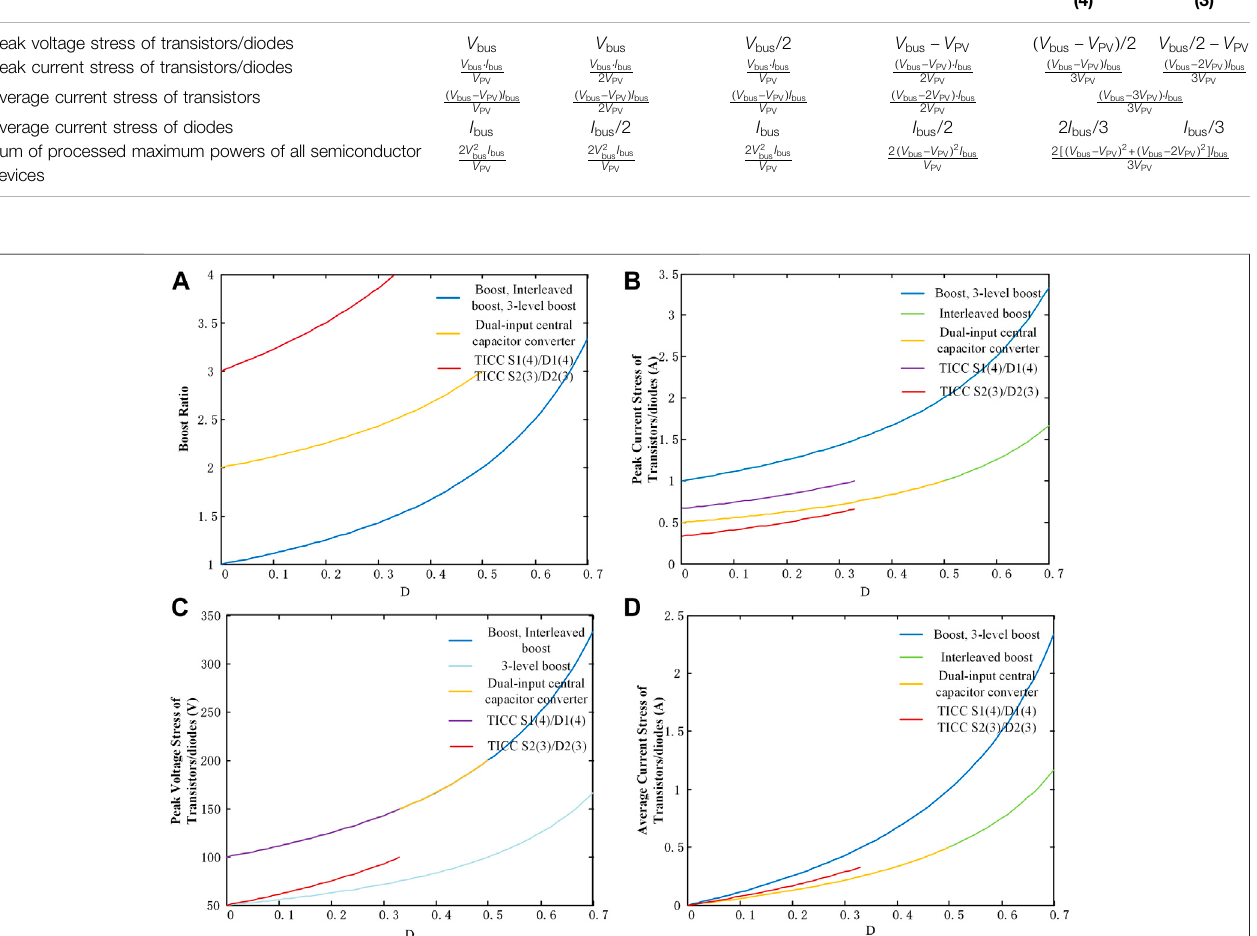
FIGURE 12 | (A) Boost ratio, (B) peak current stresses of transistors/diodes, (C) peak voltage stresses of transistors/diodes, (D) average current stresses of transistors/diodes vs. duty ratio.